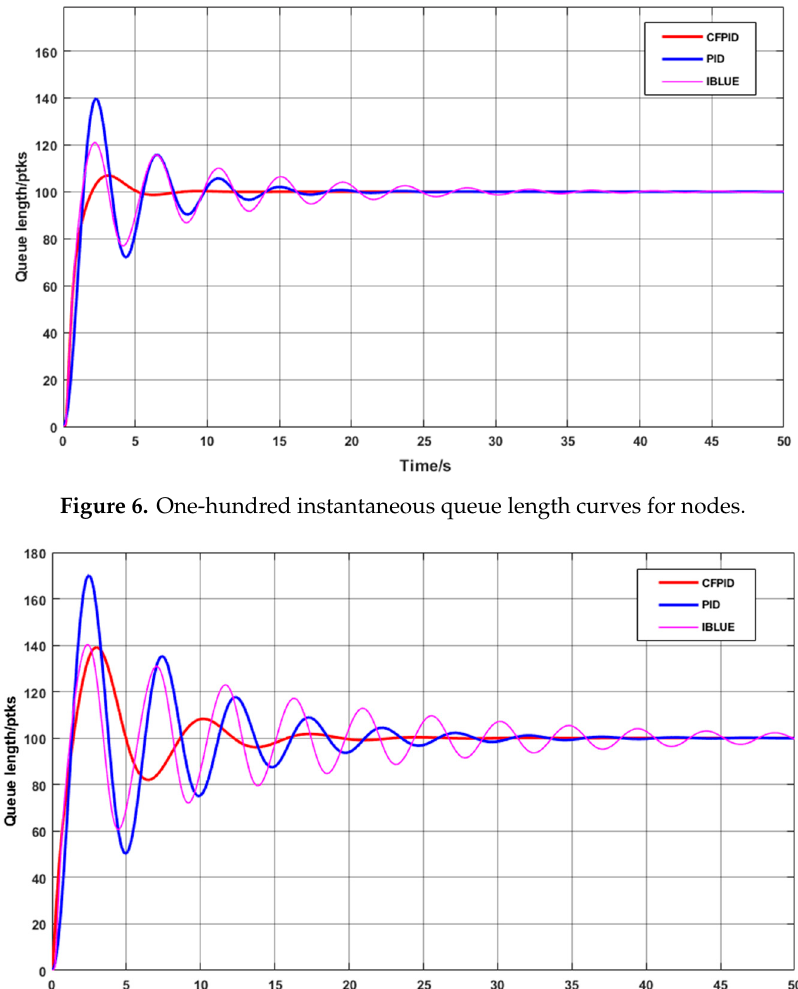
Figure 7. Two-hundred instantaneous queue length curves at node.